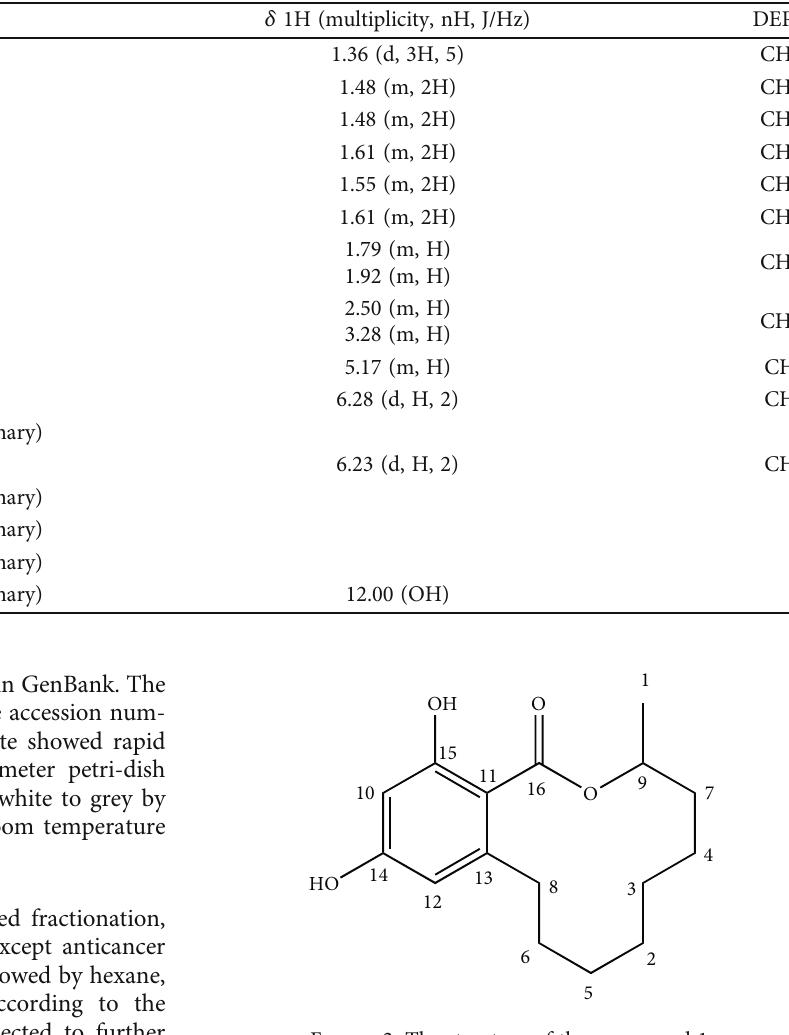
Table 2: 13 C and 1 H NMR data for the compound 1 in CDCl